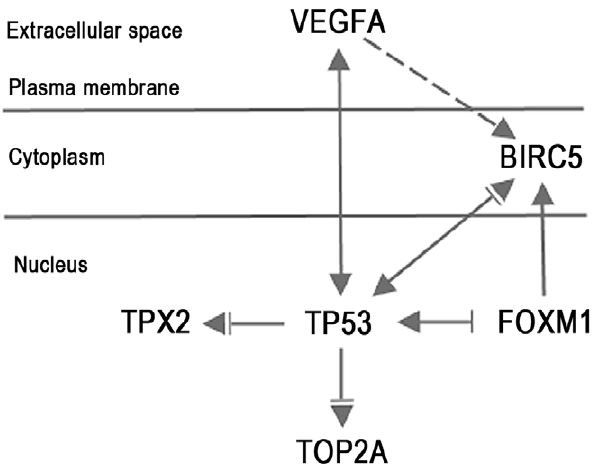
Figure 2. Molecular pathway for moderately and poorly differentiated serous ovarian carcinomas. . acts on (– direct interaction, -- indirect interaction), ) inhibits. The pathway was facilitated through Ingenuity Pathway Analysis. Abbreviations are given in Table 3.